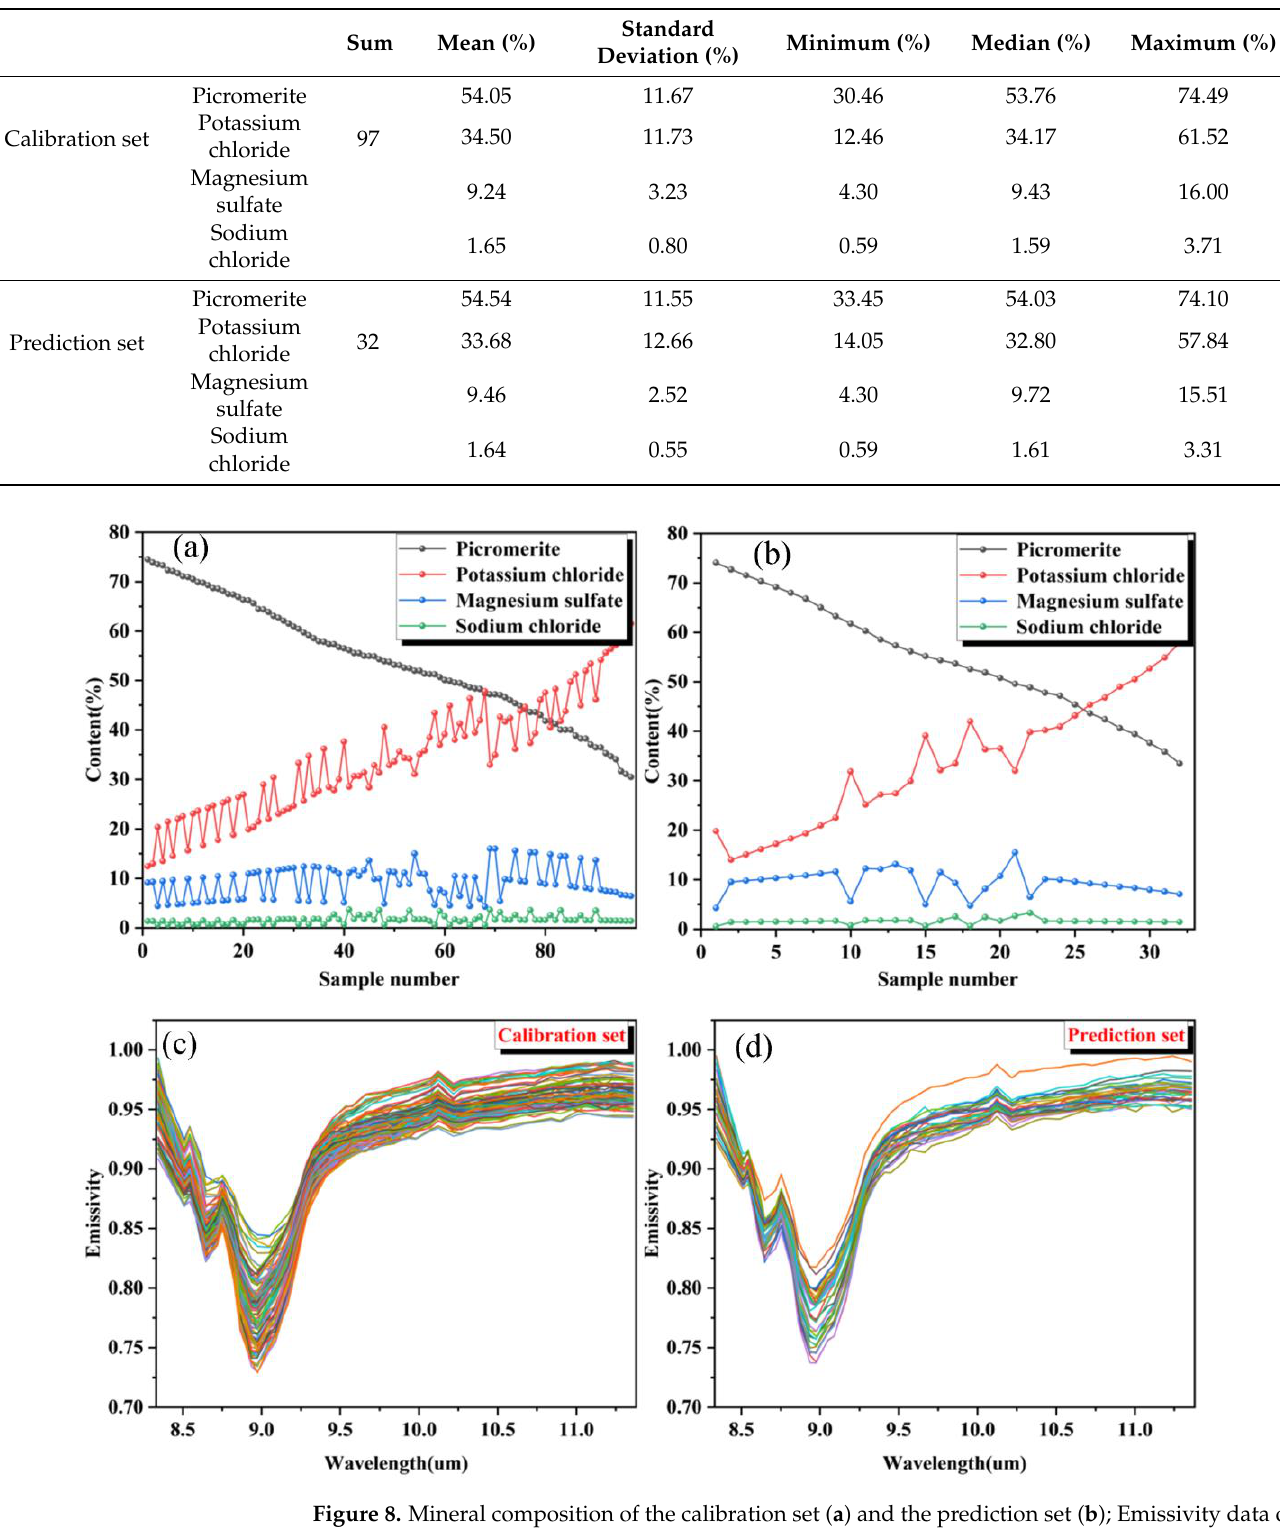
Figure 8. Mineral composition of the calibration set ( a ) and the prediction set ( b ); Emissivity data of the calibration set ( c ), and that of the prediction set ( d ).